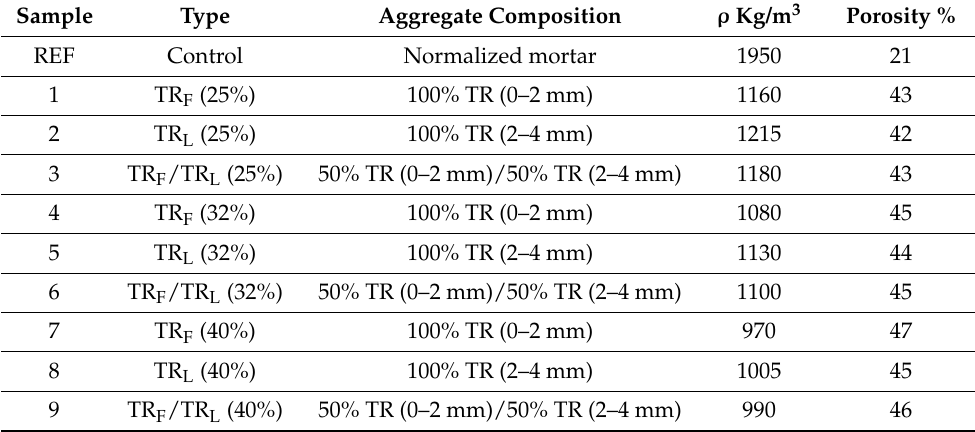
Table 1. Type, aggregate composition, density ρ , and porosity of the tire rubber (TR) mortar speci- mens. Samples prepared with 225 g of water and 450 g of cement. TR F = fine (0–2 mm) tire rubber, TR L = large (2–4 mm) tire